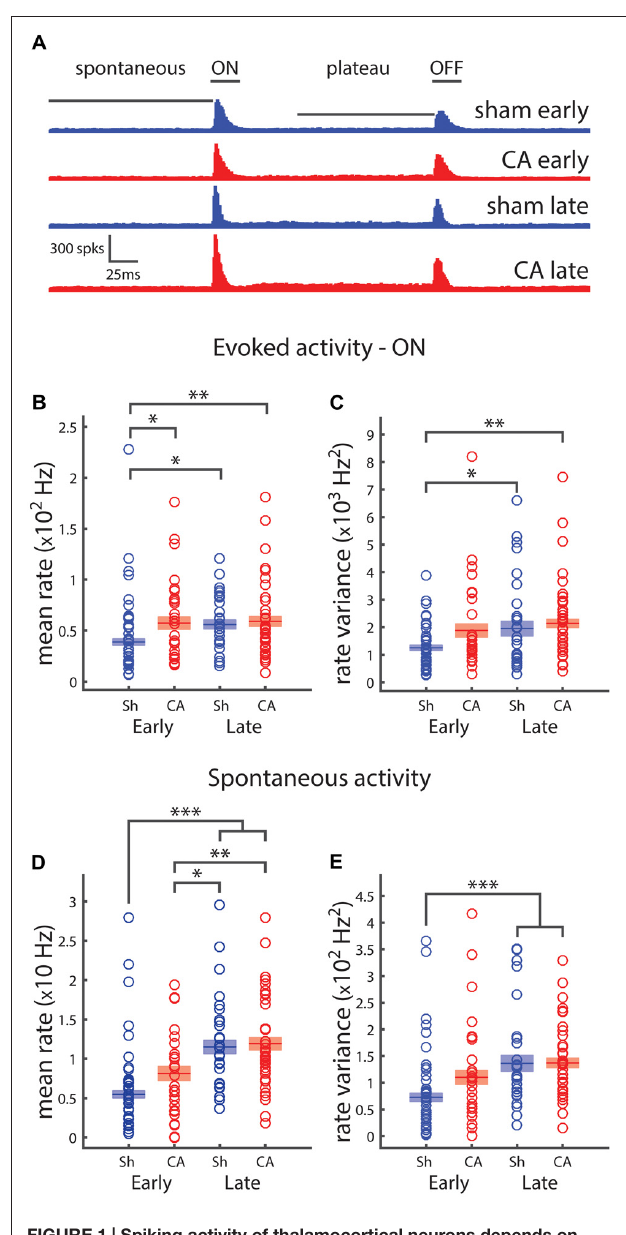
FIGURE 1 | Spiking activity of thalamocortical neurons depends on development and is affected by ischemic injury. (A) The poststimulus time histogram (PSTH) for whisker ramp and hold deflection stimuli responses of sham (blue) and cardiac arrest (CA; red) neurons during early and late periods. The horizontal bars indicate the time periods over which spikes are counted for response counts in spontaneous, ON, plateau and OFF periods. (B) Average firing rates for evoked whisker deflection (onset: ON) response. Early sham responses are significantly smaller than all other group averages. (C) Average firing rate variance of whisker responses reveal that early sham responses are less variable than both late responses. (D) Firing rates during the 150 ms spontaneous period preceding deflection. Early sham and early CA firing rates are smaller than both late groups. (E) Firing rate variance of whisker responses reveals that early sham spontaneous activity is less variable that both late groups. Horizontal bars and rectangular shaded regions in (B–E) indicate mean ± S.E.M. of the α -trimmed data sets. ∗ Indicates p < 0.05, ∗∗ indicates p < 0.01 and ∗∗∗ indicates p < 0.001.